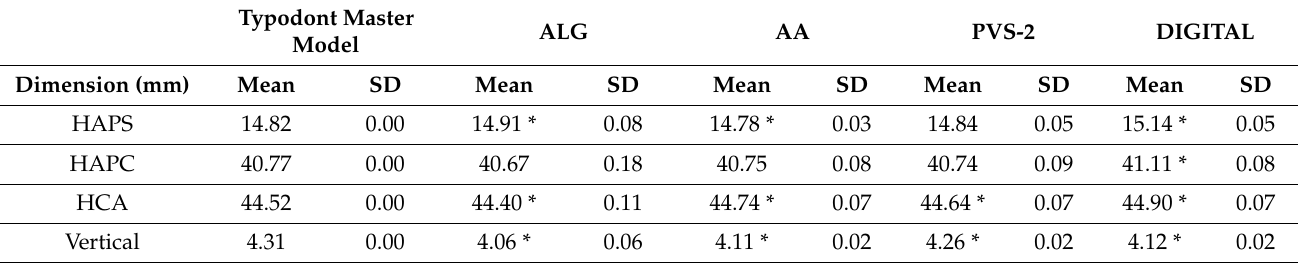
Table 1. Measurements of stone casts, printed models, and the typodont master model